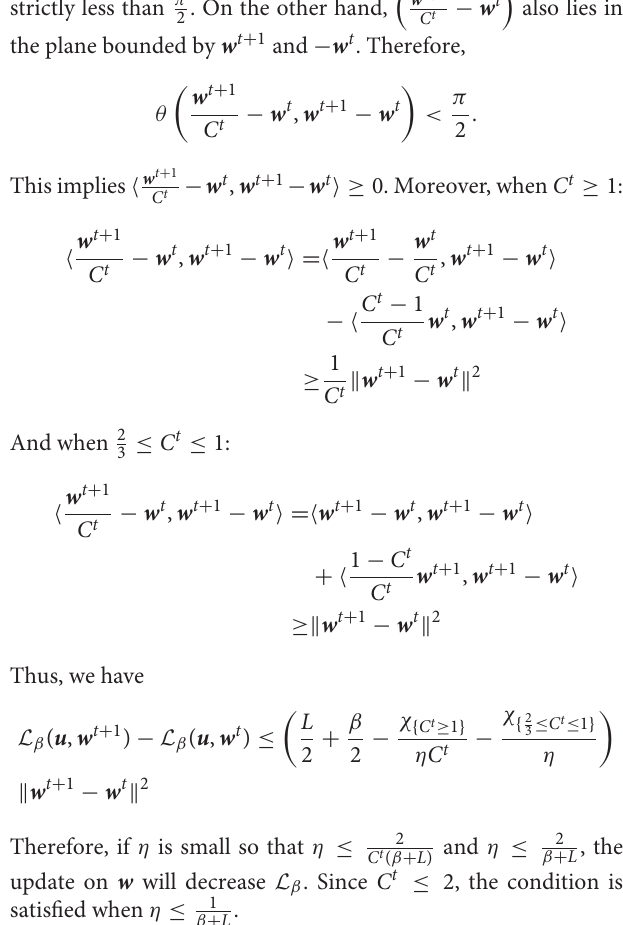
FIGURE 3 | Worst case of the update on w t